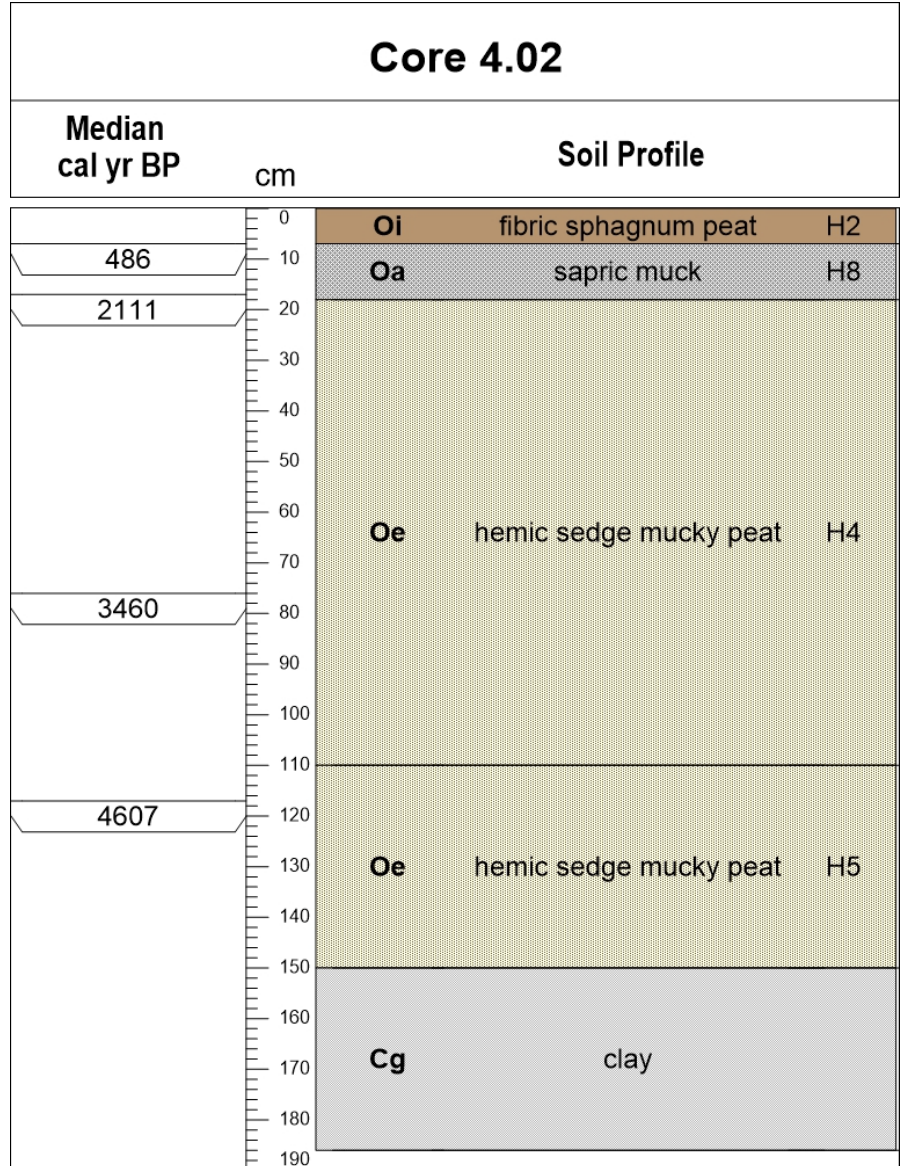
Figure 4. Soil profile of Core 4.02, representing Type A (H) profiles. Type C soil profiles had a distinct horizonation (Figures 3 and 6) with a catotelm layered as a hemic soil horizon, underlain by a sapric horizon, underlain by another hemic horizon (HSH). This distinct Type C (HSH) horizonation was the most numerous of the 88 profiles examined and occurred in four of the five peatlands (Table 2 and Figure 2). This profile type was more numerous in larger and deeper peatlands. Type C (HSH) soil profiles occurred clustered in the center of Peatlands 2, 3, and 4, and comprised almost all of Peatland 5. Of the 27 Type C soil profiles, three had laboratory data and radiocarbon dates, one had only radiocarbon dates, and five had only laboratory data. Four cores (3.13, 4.19, 5.12, and 5.17) with sequential radiocarbon dates had Type C (HSH) soil profiles, with a catotelm sapric horizon dating to the Northgrippian Age (Figure